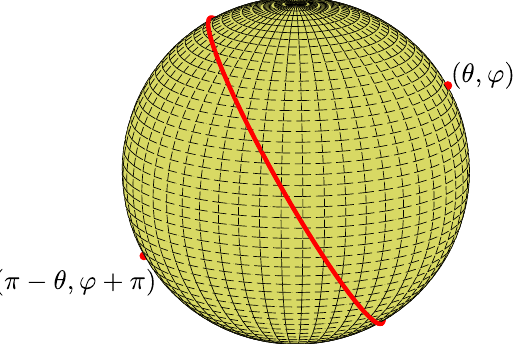
Figure 6. In the case of the great circles, d = 0, two antipodal spherical points (red), one at each hemisphere, define the same great